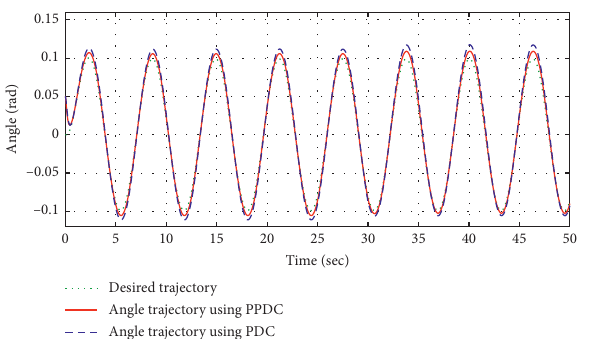
Figure 4: Angle tracking trajectories using PDC and PPDC approaches.